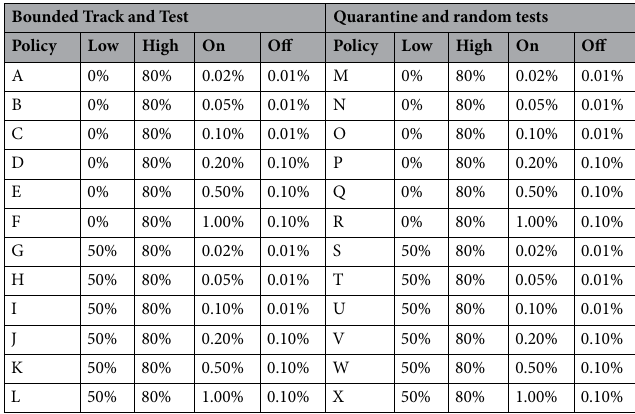
Table 1. On–Off policies corresponding to the results in Fig. 5. The left columns are On–Off policies combined with the Track and Test method with a bounded daily test capacity of 0.5% . The right columns are with the Quarantine method and the same number of tests distributed at random. The middle line separates between the “strict” and “trembling-hand” On–Off